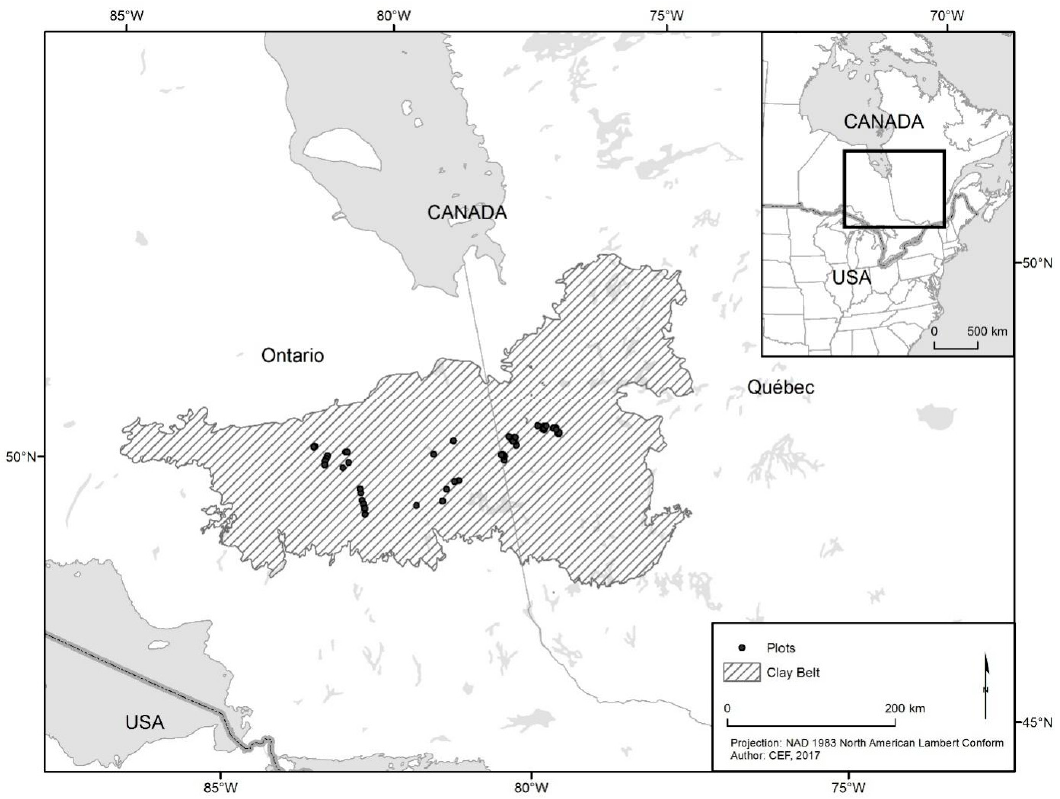
Figure 1. Map of the research area in Clay Belt region in Quebec and Ontario. Black dots represent study sites; many are overlapped on the map.